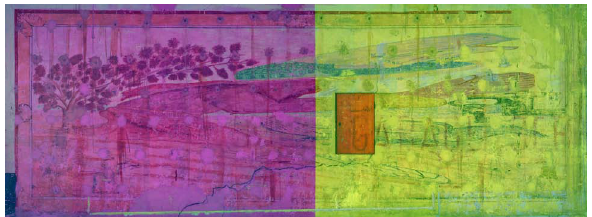
Figure 10: Example of synthetic VIS/IR/UV false-color or- thophotomosaic ; on the left IR(R)/UV(G)/VIS(B), on the right IR(R)/VIS(B)/UV(G) on Anamorphosis case-study